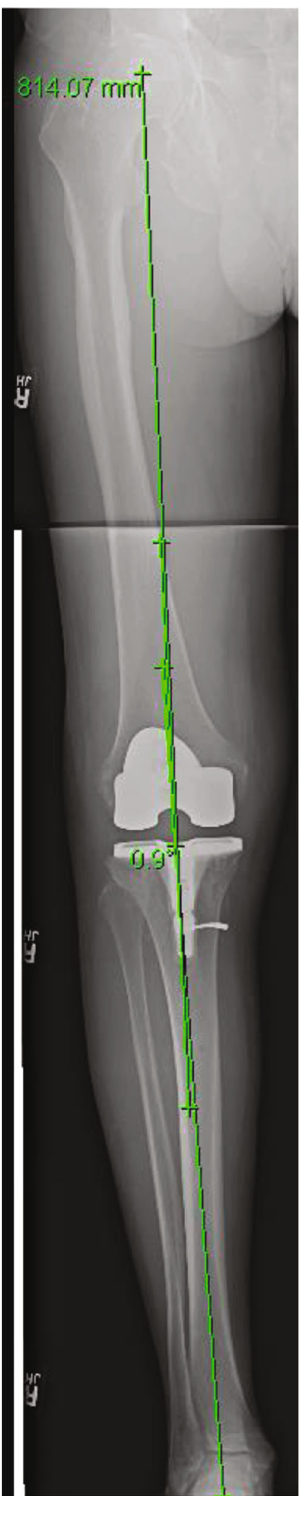
Figure 17: Postoperative full-leg standing radiograph of the left leg for Case 4 showing the corrected neutral mechanical alignment following TKA in 0.9 degrees if varus.